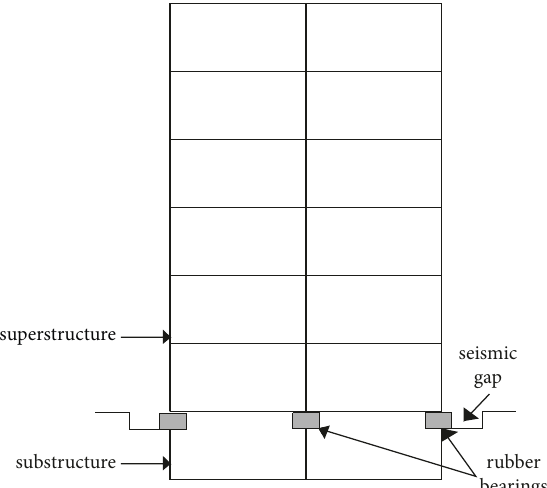
Figure 1: Building with seismic isolation.